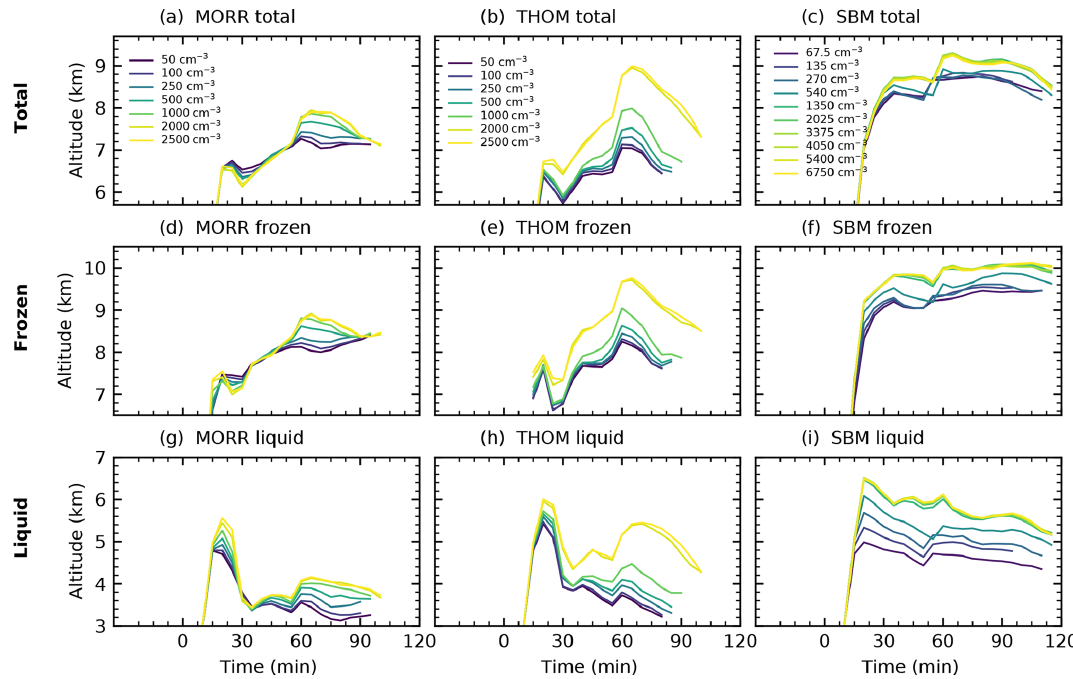
Figure 13. Altitude of the centre of gravity of the cloud and the individual phases in the analysed right-moving cell for the three different microphysics schemes (Morrison: a , d , g , Thompson: b , e , h , SBM: c , f , i ) in